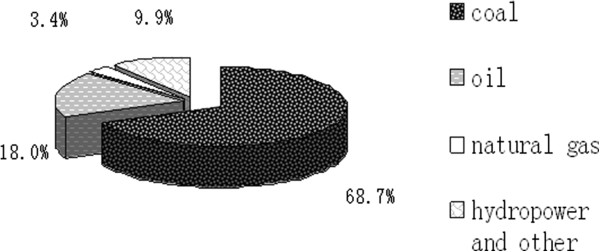
Energy structure of China in 2009 (Source: [[2][10][11]]).